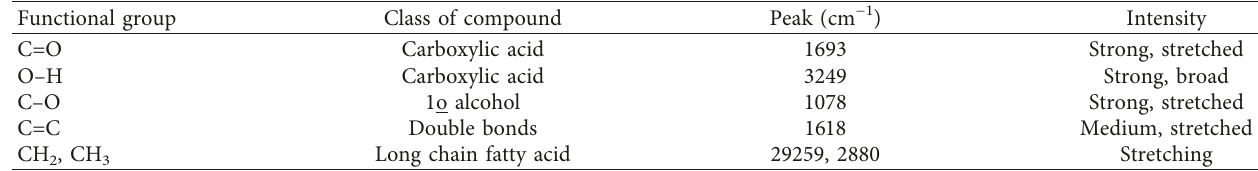
Figure 4: Infrared spectrum of SFAEPAS-3. Table 1: Functional groups of compounds present in SFAEPAS-3 using